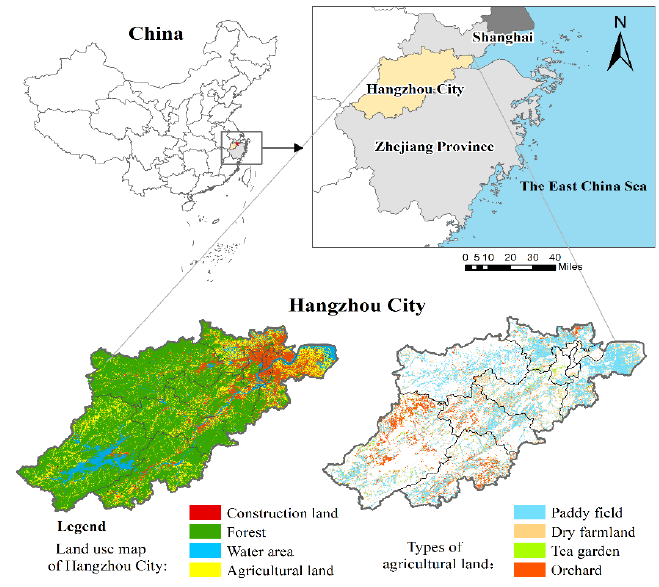
Figure 1. The location of the study area of Hangzhou.